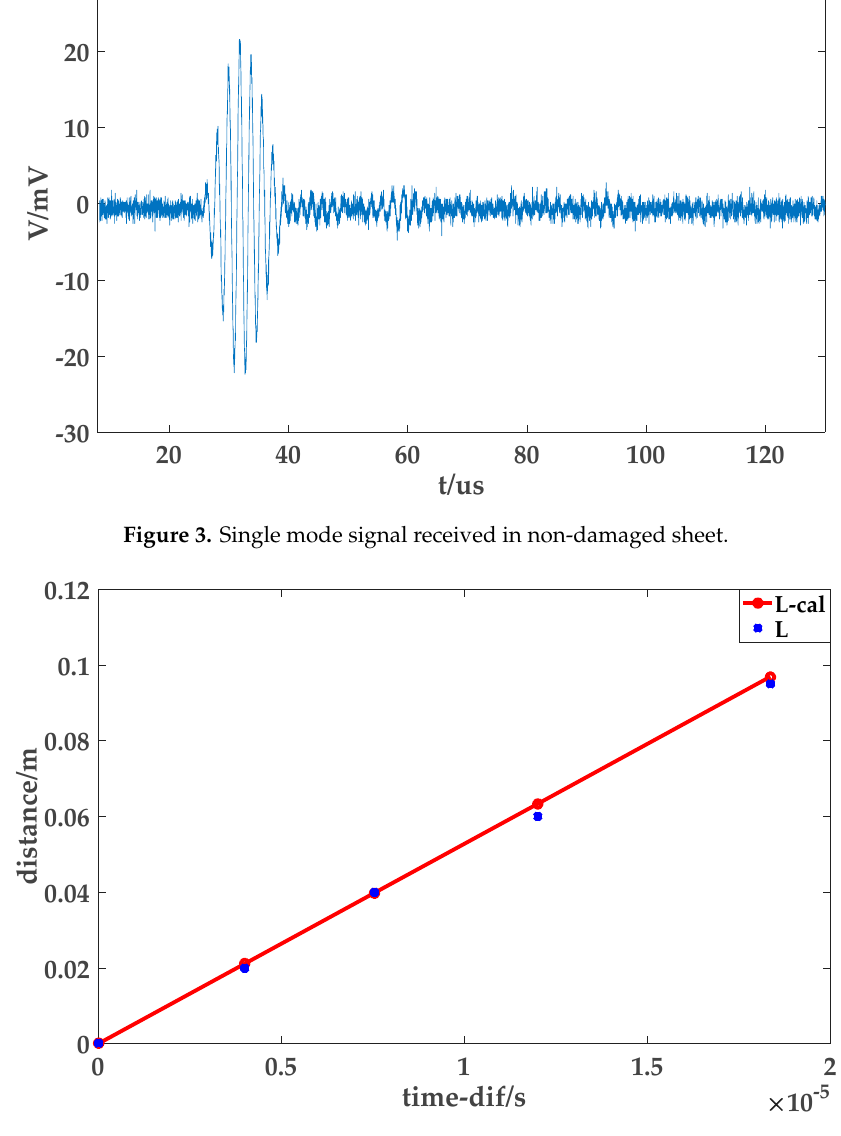
Figure 4. Comparison of actual distance and theoretical distance .